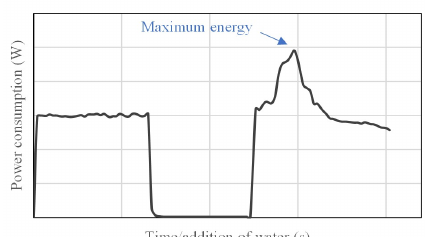
Figure 4. Representation of the mixing energy test result, with increasing energy consumption as a function of water addition over time